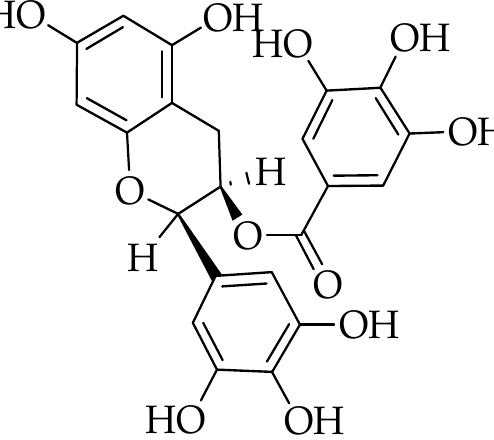
Figure 3. The chemical structure of epigallocatechin gallate.